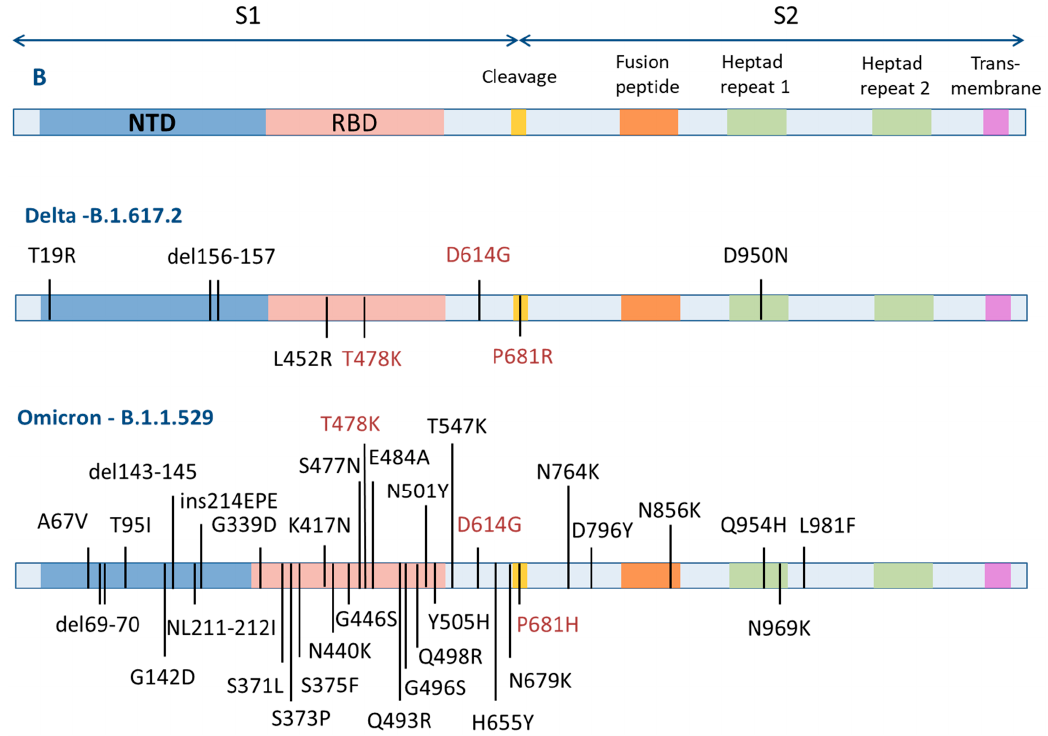
Figure 7. Mutations of amino acid residues in different strains of the SARS-CoV-2 virus considered in this study.